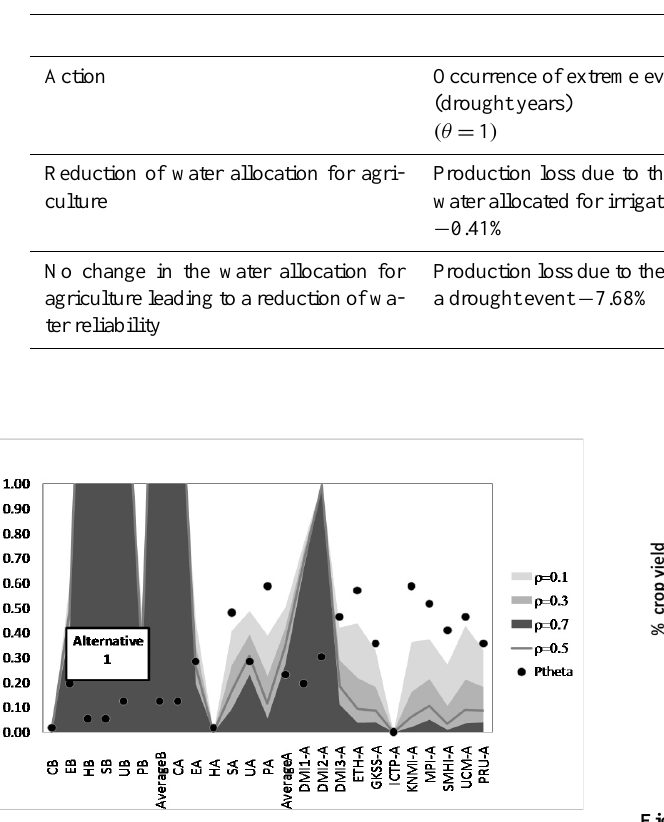
Table 9. Payoff matrix (reduction of rice yield) for Prudence-A scenario.